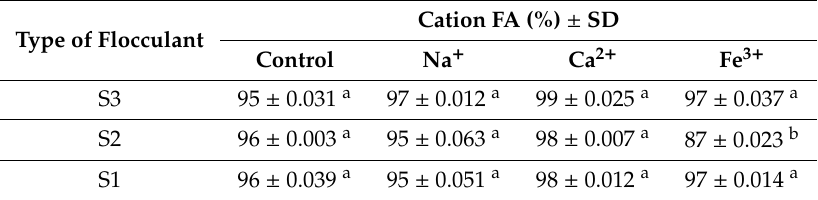
Table 2. E ff ect of cations on flocculation activity of nanoparticles. Table 2. Effect of cations on flocculation activity of nanoparticles. Type of Flocculant